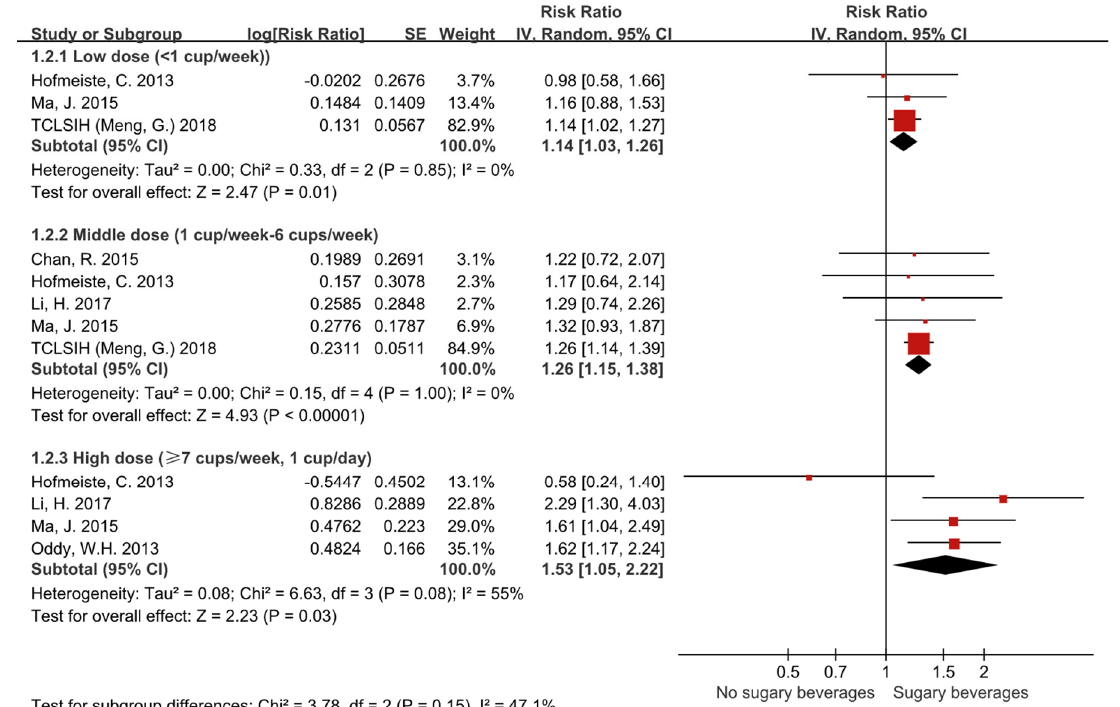
Figure 3. Forest plots showing that the consumptions of low doses ( < 1 cups / week), middle doses (1–6 cups / week) and high doses ( ≥ 7 cups / week) of sugar-sweetened beverages increased the relative risk of NAFLD by 14%, 26% and 53%, respectively.